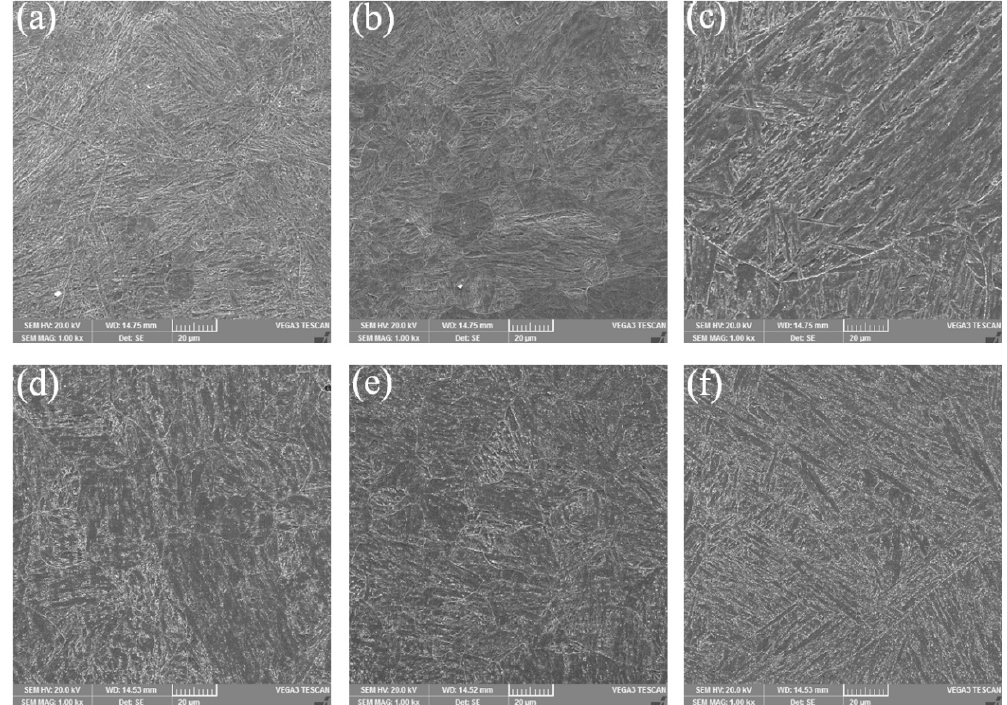
Figure 3. Typical SEM images of the heat-affected zone (HAZ) ( a , b ), ( d , e ) and base metal ( c ), ( f ) of CB2 steel: ( a )–( c ) without PWHT and ( d )–( f ) with PWHT at 730 °C for 2 h.